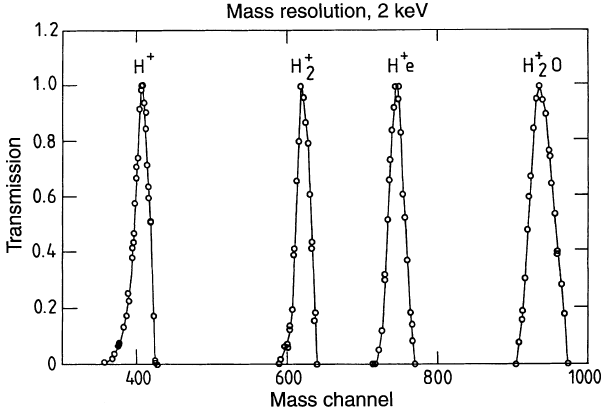
Fig. 2. Mass resolution of the ION-1/2 spectrometers for 2-keV particles